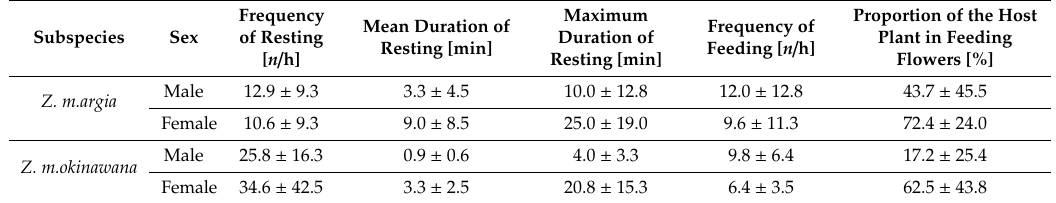
Table 2. Resting-related and feeding-related behaviors in the two subspecies of Z. maha